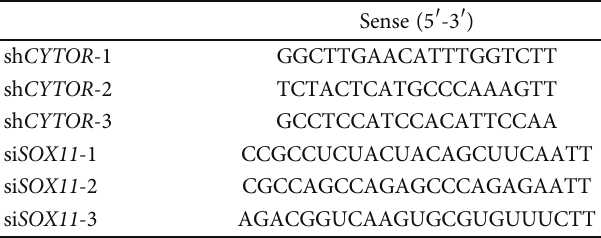
Table 1: Primer sequences used in this